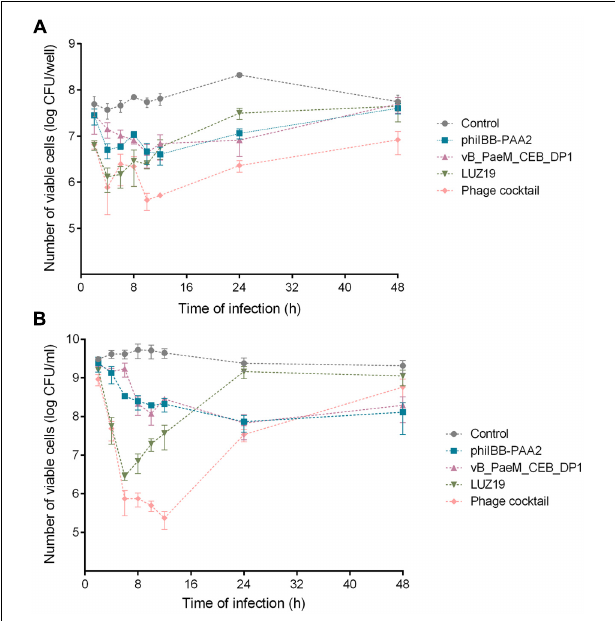
FIGURE 1 | Infection of Pseudomonas aeruginosa PAO1 biofilms (A) and planktonic cultures (B) with phages phiIBB-PAA2, vB_PaeM_CEB_DP1 and LUZ19, individually or in cocktail. Both experiments were performed using a MOI of 0.1. Error bars represent standard deviations from three independent experiments performed in